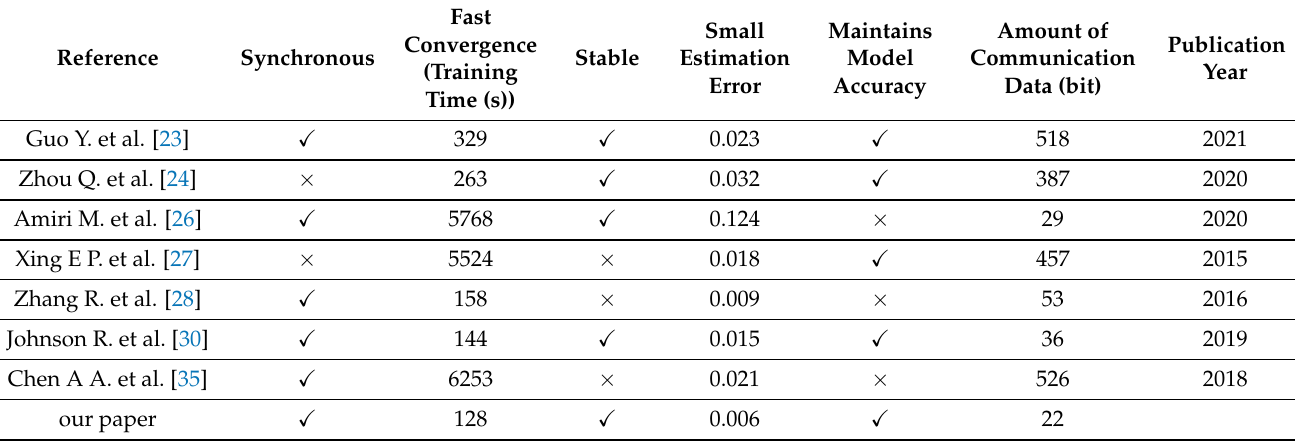
Table 1. Comparison of different working